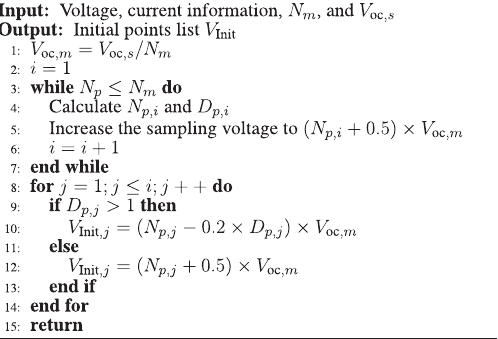
Algorithm 2: Determination of initial points.